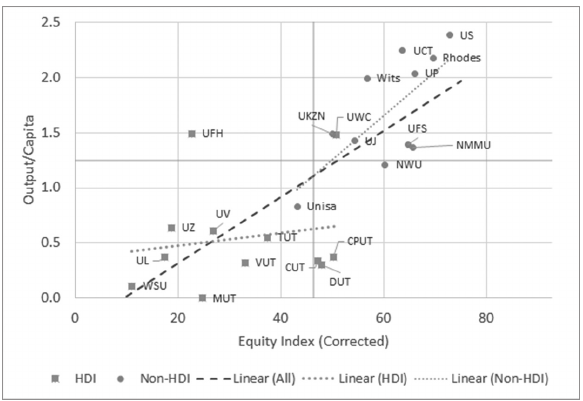
Output per capita versus the corrected Equity Index by